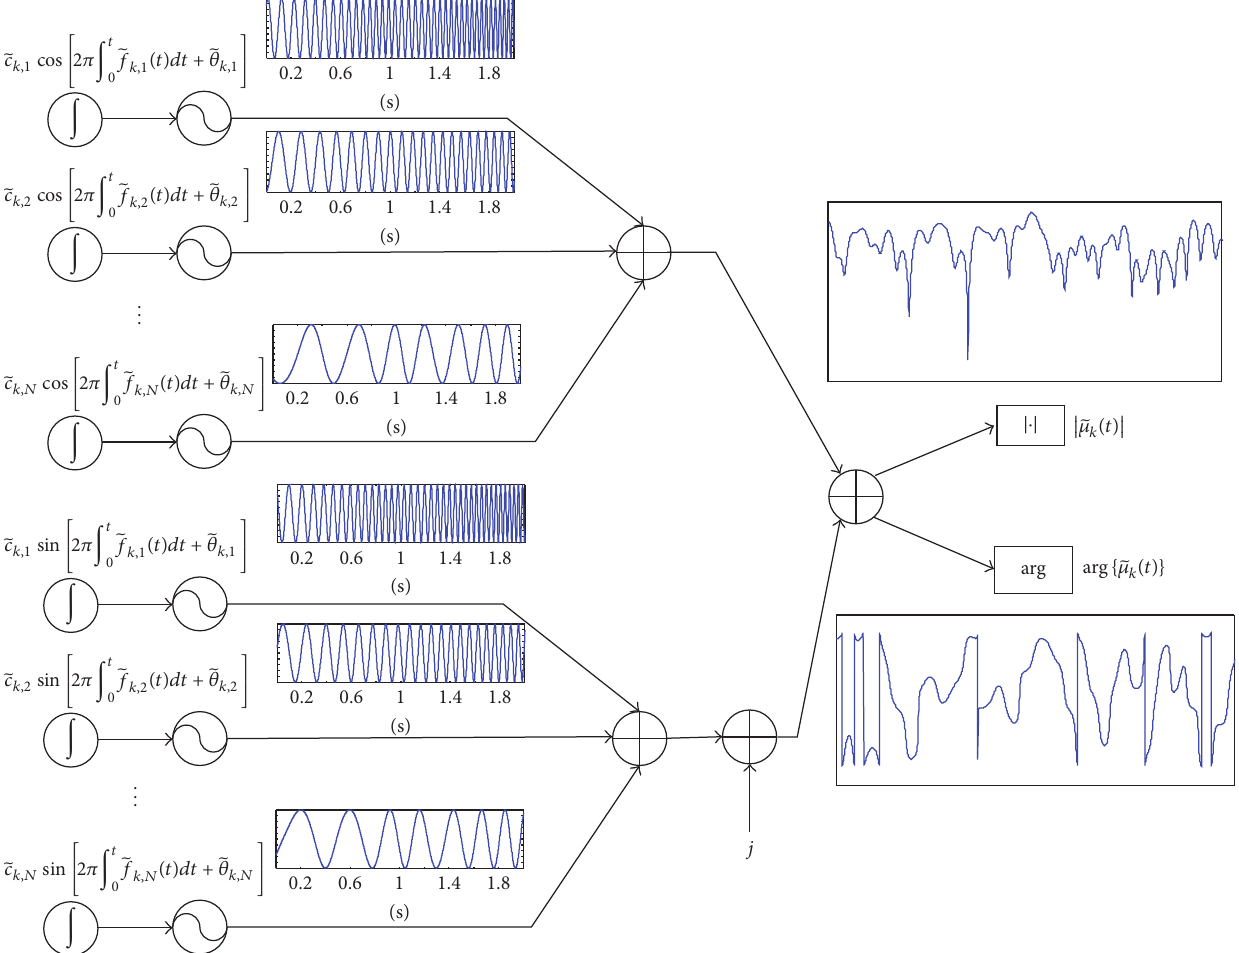
Figure 2: Simulation model for nonstationary Rayleigh fading by a finite sum of frequency modulated signals. |̃𝜇 𝑘 (𝑡)| and arg {̃𝜇 𝑘 (𝑡)} are the amplitude and phase of the simulated fading process,